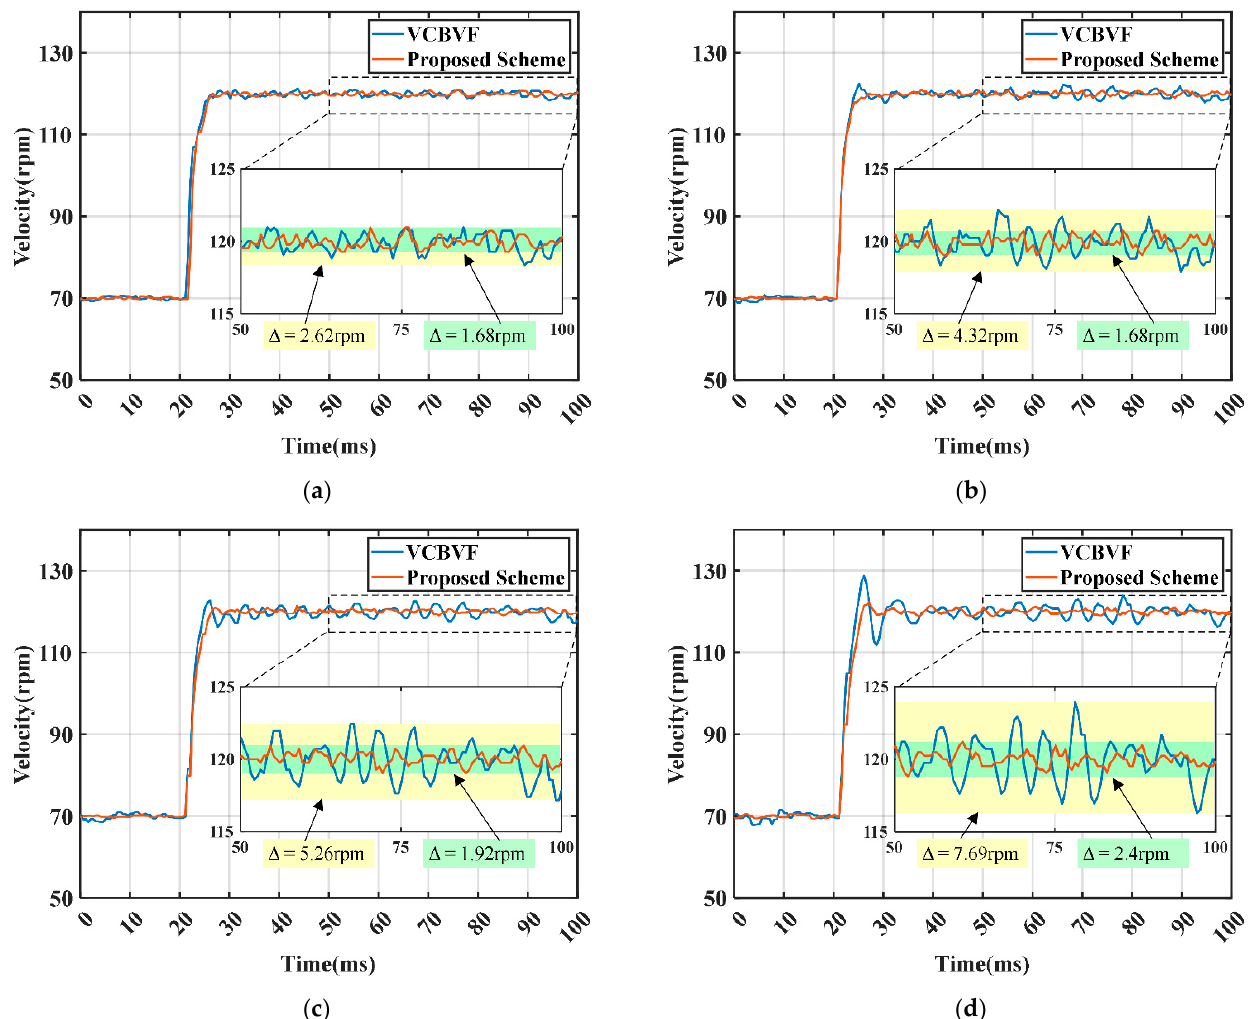
Figure 12. Velocity responses of the USM with different control schemes: ( a ) 0 Nm; ( b ) 0.1 Nm; ( c ) 0.2 Nm; and ( d ) 0.3 Nm. Table 2. Control performance of the TRUSM.